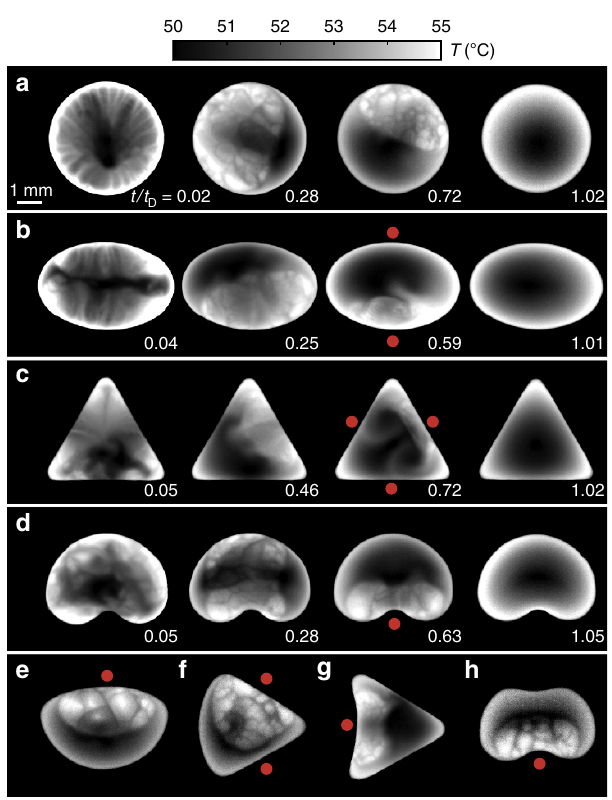
Figure 4 | Flow dynamics of binary-mixture drops. Infrared images (top view) illustrating the ethanol depletion occurring in evaporating binary-mixture drops (ethanol–water) with different shapes. In all cases the initial volume is V ¼ 7 m l (25% vol ethanol, 75% vol distilled water), P ¼ 15mm and T w ¼ 55 (cid:2) C. The interfacial ‘turbulence’ gives a measure of the ethanol concentration. The depletion time is t D ¼ 55.2s ± 6.9%. In non-spherical drops, the segregation point always corresponds to the region where the contact-line curvature k cl is minimum; the red dots mark these locations. ( a ) k cl ¼ 0.42mm (cid:3) 1 , ( b ) 0.24 r k cl r 0.79mm (cid:3) 1 , ( c ) 0 r k cl r 2.5mm (cid:3) 1 , ( d ) (cid:3) 1.87 r k cl r 0.78mm (cid:3) 1 . ( e – h ) Other shapes with different principal curvature combinations (namely, positive–positive, zero–positive, negative–zero, negative–negative). Sample movies available in the Supplementary Materials (See Supplementary Movies 1 and 2).